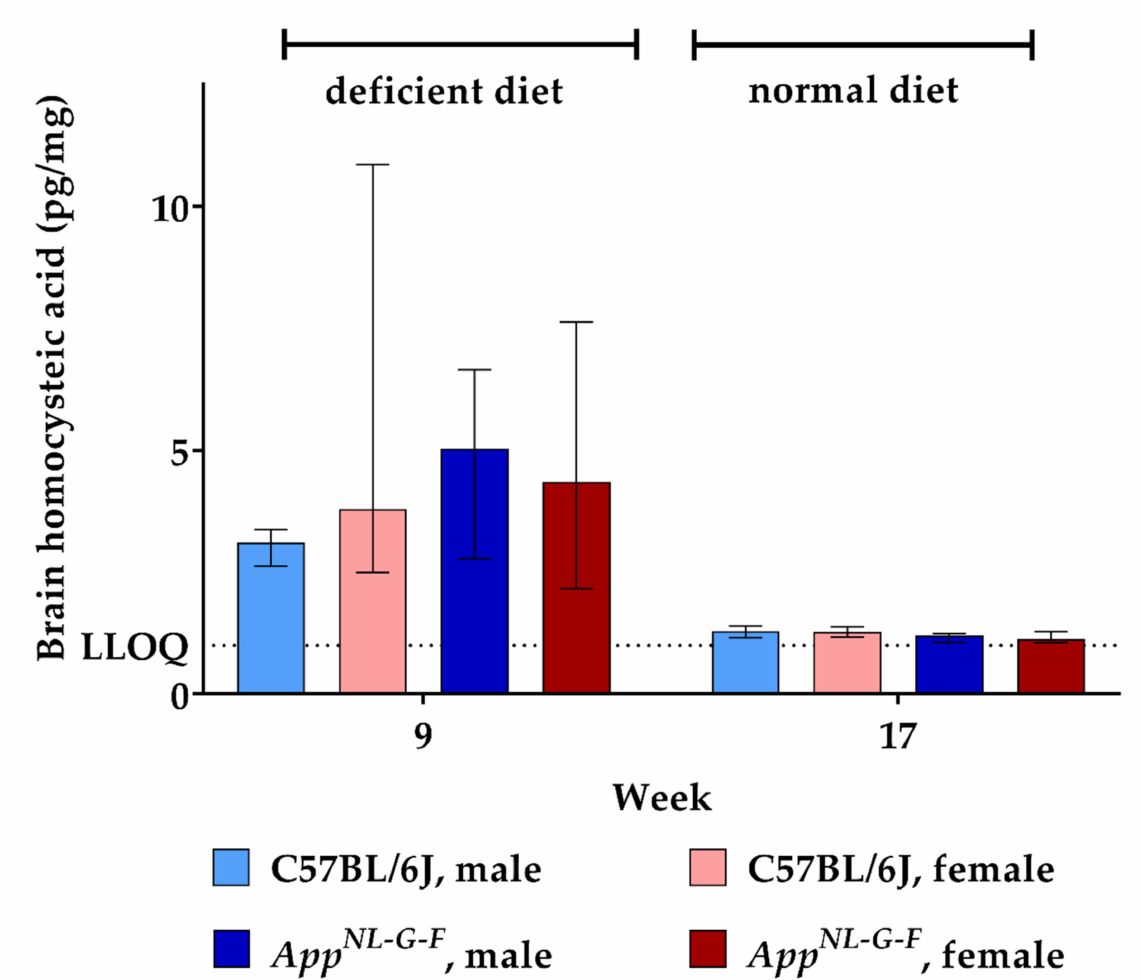
Figure 6. Homocysteic acid levels in brain tissue in C57BL/6J wild type and App NL-G-F knock-in mice, data are depicted for males and females separately for experimental week 1–17: baseline measurement (w. 1), diet deficient in vitamin B6, B12 and folate (for 8 w.), balanced normal chow (for 8 w.); all brain samples were analyzed using a combination of liquid chromatography with tandem mass spectrometry and statistically tested non-parametrically using the Kruskal-Wallis test; data are presented as median ± interquartile range (IQR); extreme outliers beyond 3xIQR have been